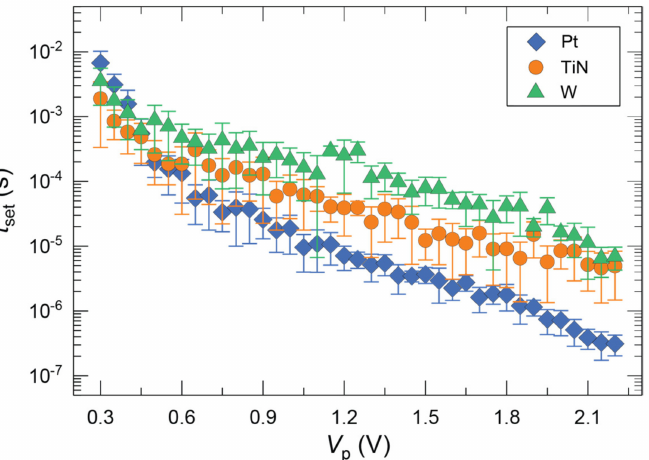
Figure 7. SET switching kinetics of Ag/HfO 2 /CE DM cells for the three counter electrodes of ( a ) Pt, ( b ) TiN, and ( c ) W. The median values and median absolute deviations (MAD) of the experimental data are displayed using color-filled symbols and vertical lines, respectively. The TiO x and WO x interfacial oxides are shown with light orange and light green colors, respectively. A 100 k Ω series resistor ( R series ) was used to limit the maximum current in all measurements.